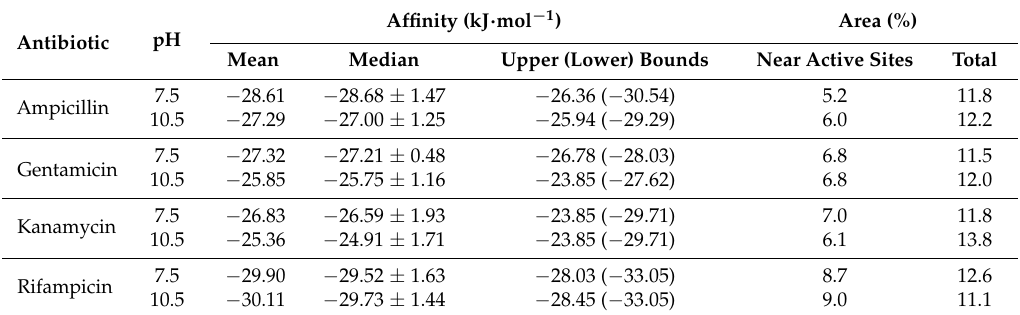
Table 2. Calculated values of affinity of various antibiotics to His 6 -OPH dimer and solvent accessible areas occupied by antibiotics and expressed as percentage of the total area of His 6 -OPH dimer. The area was calculated simultaneously for all the obtained models using PyMol functionality (get_area) with default